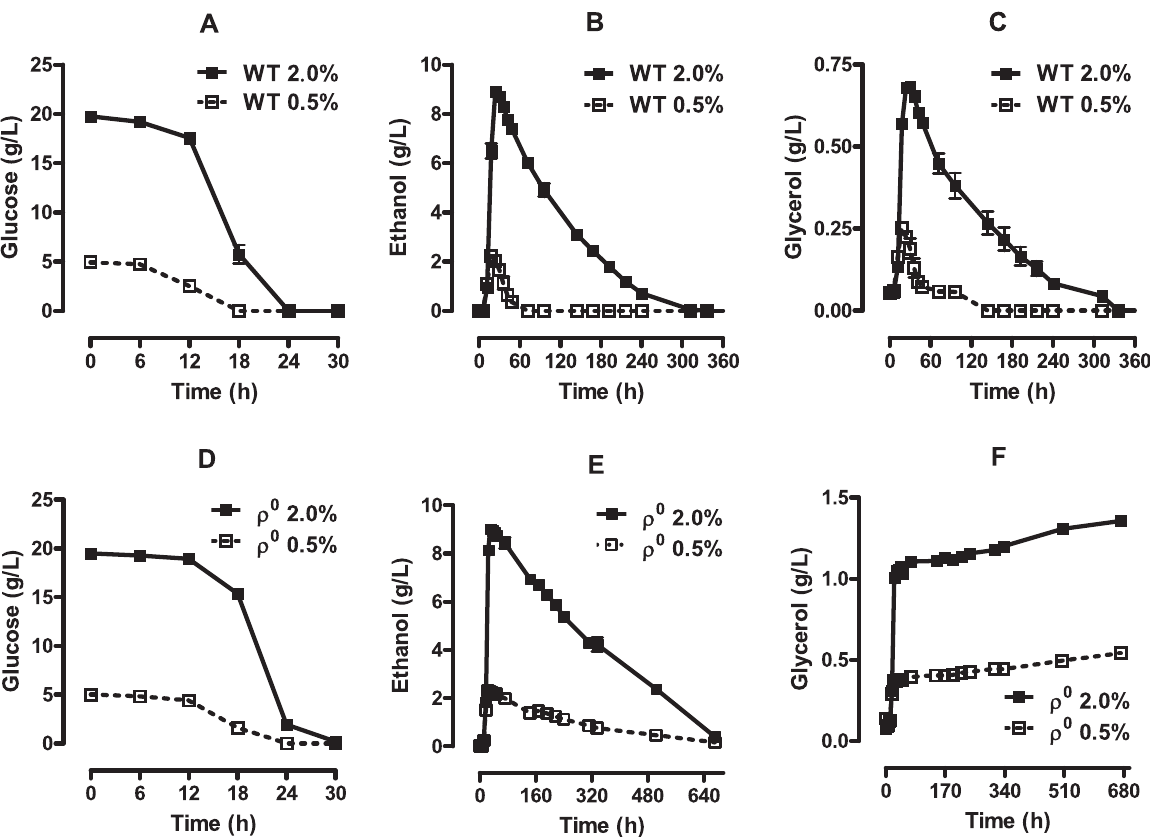
Figure 2. Substrate consumption during chronological aging in S.cerevisiae . Glucose (Panels A and D), ethanol (Panels B and E) and glycerol (Panel C and F) concentrations in the culture media during WT (Panels A-C) and r 0 (Panels D-F) S. cerevisiae chronological lifespan were measured as described in Materials and Methods.